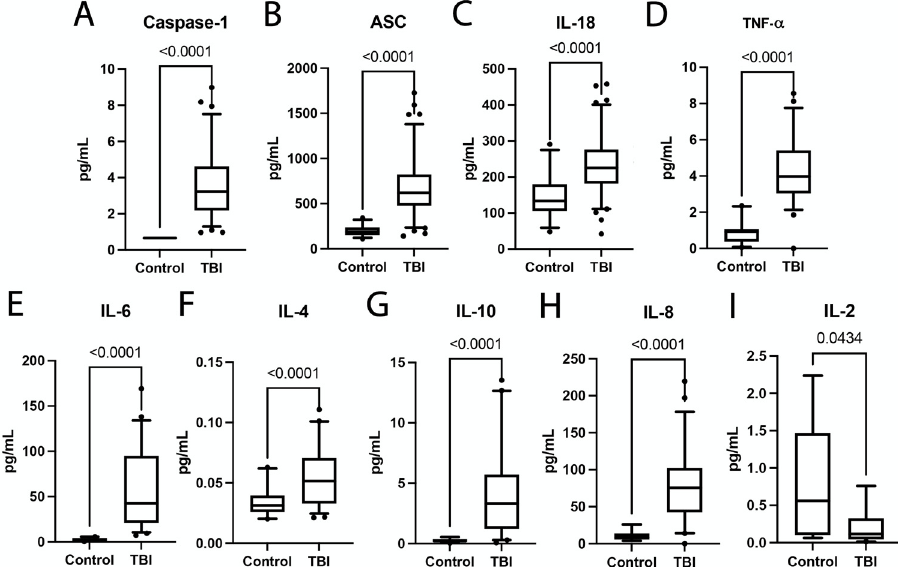
Figure 1. Inflammatory cytokines and Inflammasome Proteins are Elevated after TBI. Simple Plex Assay and MSD-VPLEX Inflammatory Panel of blood serum from TBI patients and age-matched controls. Data were analyzed utilizing a two-tailed Mann–Whitney nonparametric test. Inflammatory cytokines and inflammasome proteins that showed a statistically significant increase after TBI were plotted. Box and whisker plots show mean and quartiles for each inflammatory protein of interest with respective p values listed above. Dots correspond to data points outside the 5th and 95th